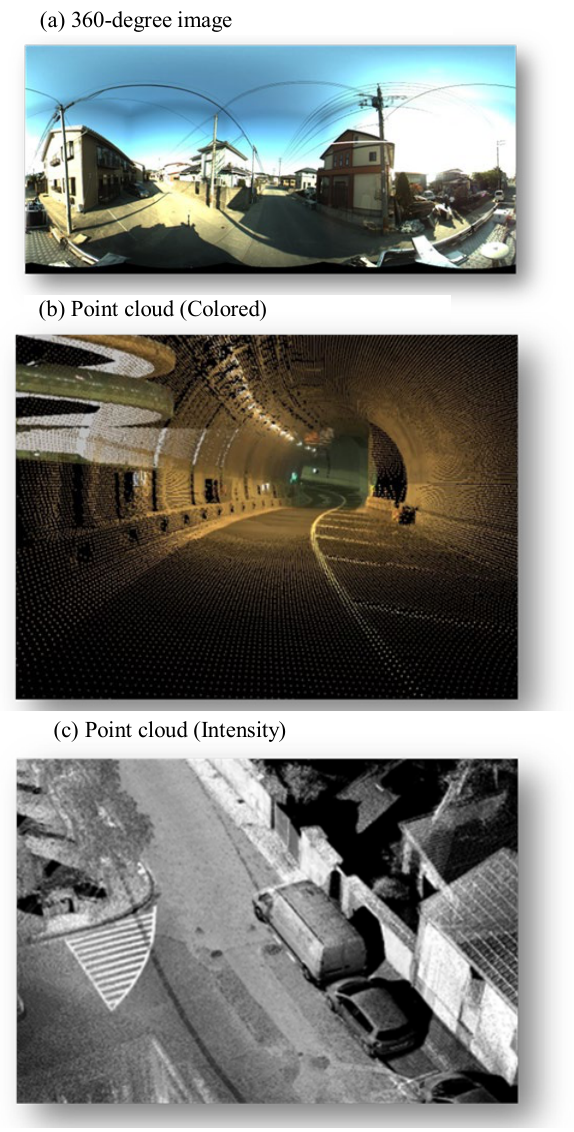
Figure 3. Data captured by MMS